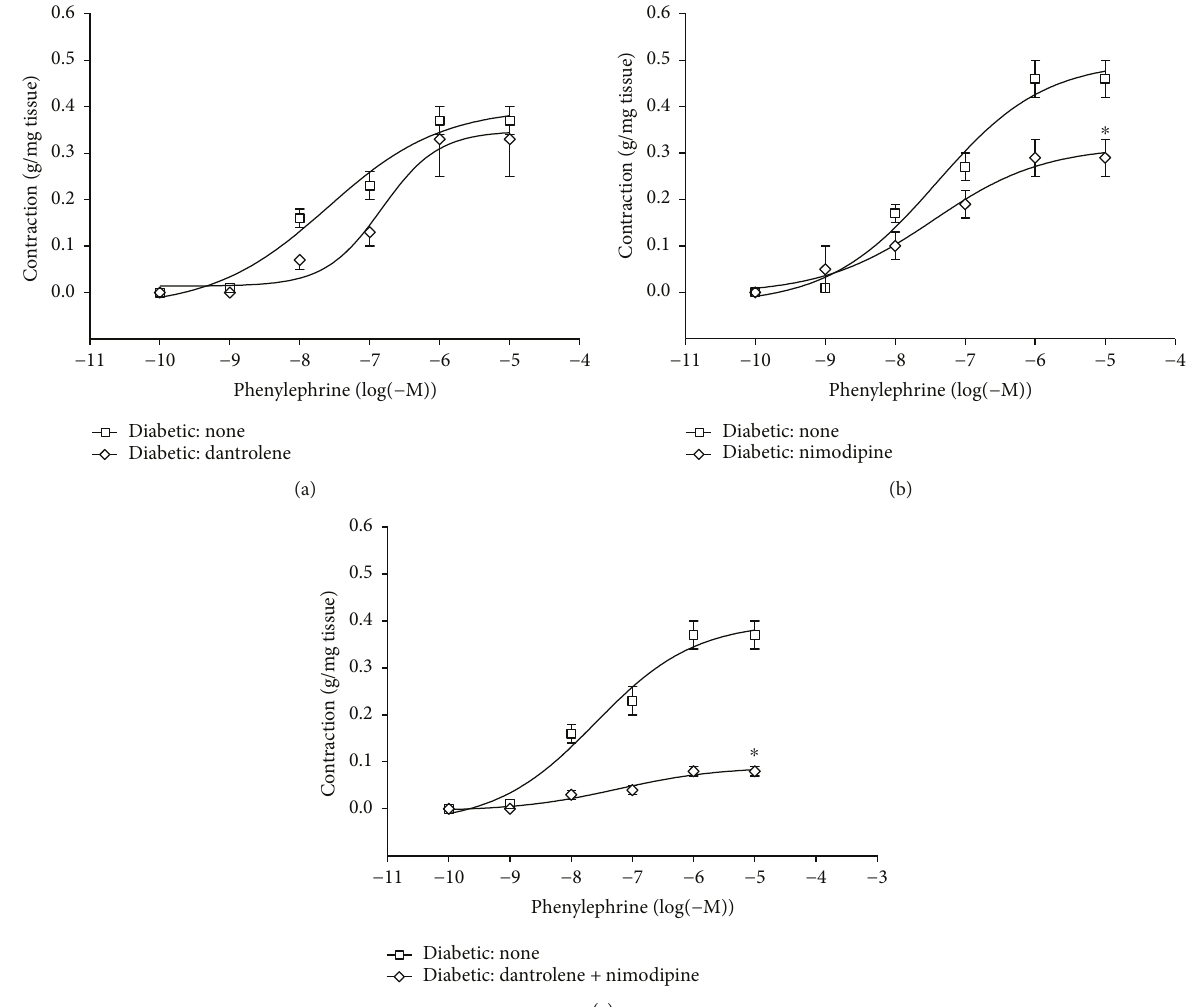
Figure 2: Cumulative concentration-response curves (from 0.1nM to 10 μ M) for the phenylephrine- (PHE-) induced contraction of aortic rings from STZ diabetic rats only before and after a 30min incubation period with 50 μ M dantrolene (a), with 50nM nimodipine (b), and with both drugs in combination (c). The values shown are the means ± SEM of 6 to 9 animals per group. ∗ P < 0 05 , when comparing E and after incubation with nimodipine and with dantrolene and nimodipine in